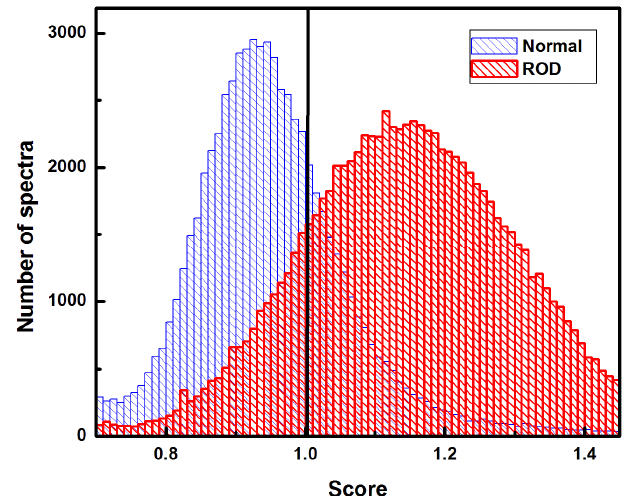
Figure 5. Combined histograms resulted from statistical investigations using all four biomarkers concurrently. Distribution of scores of more or less than 1 were assigned to each ROD and normal spectrum, respectively.